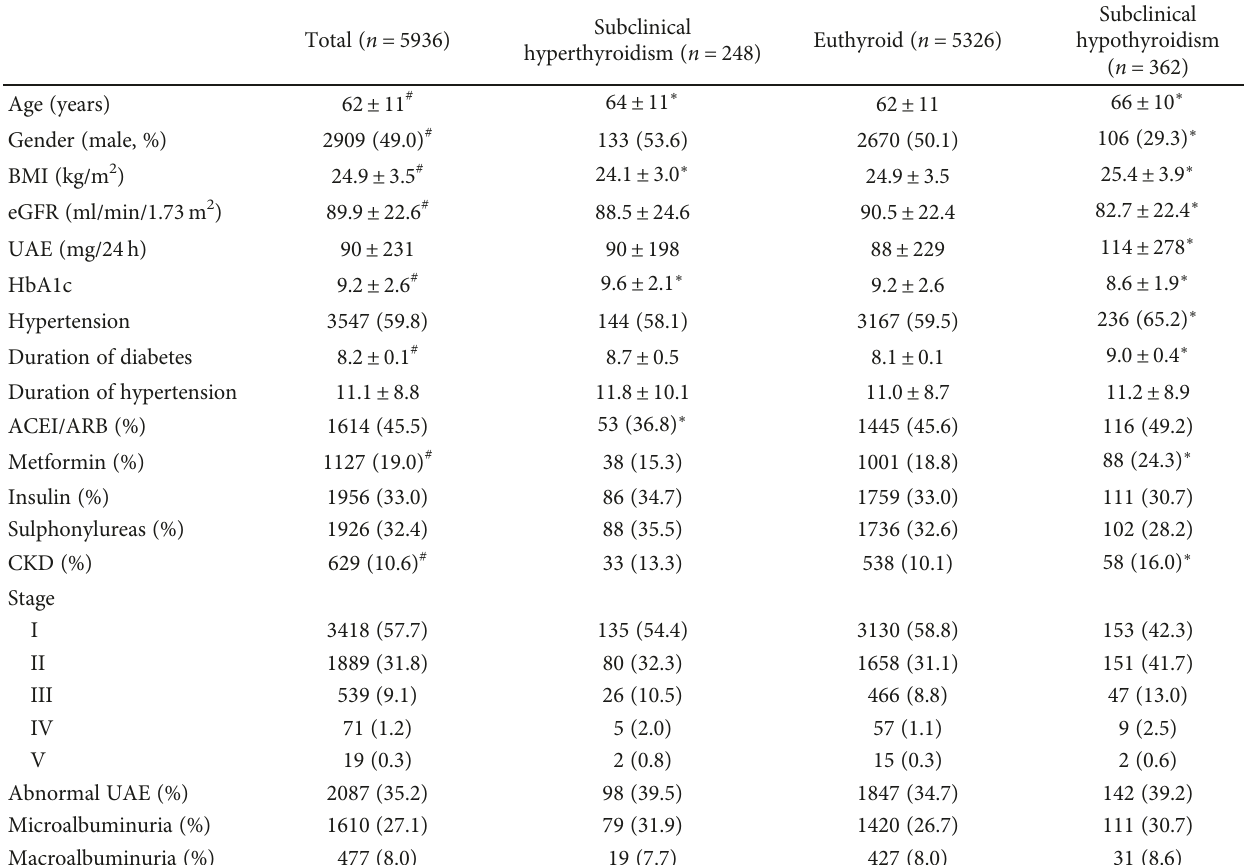
Table 1: Clinical characteristics of the study participants in di ff erent thyroid function